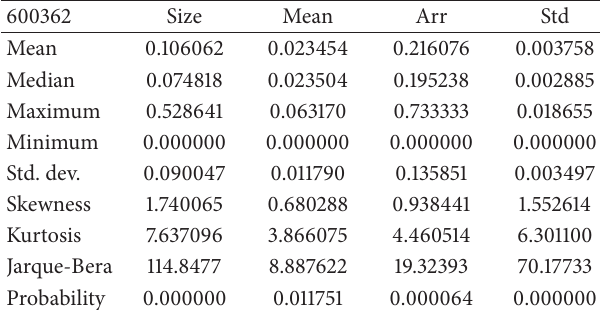
Table 14: Descriptive statistics for individual stock average jump